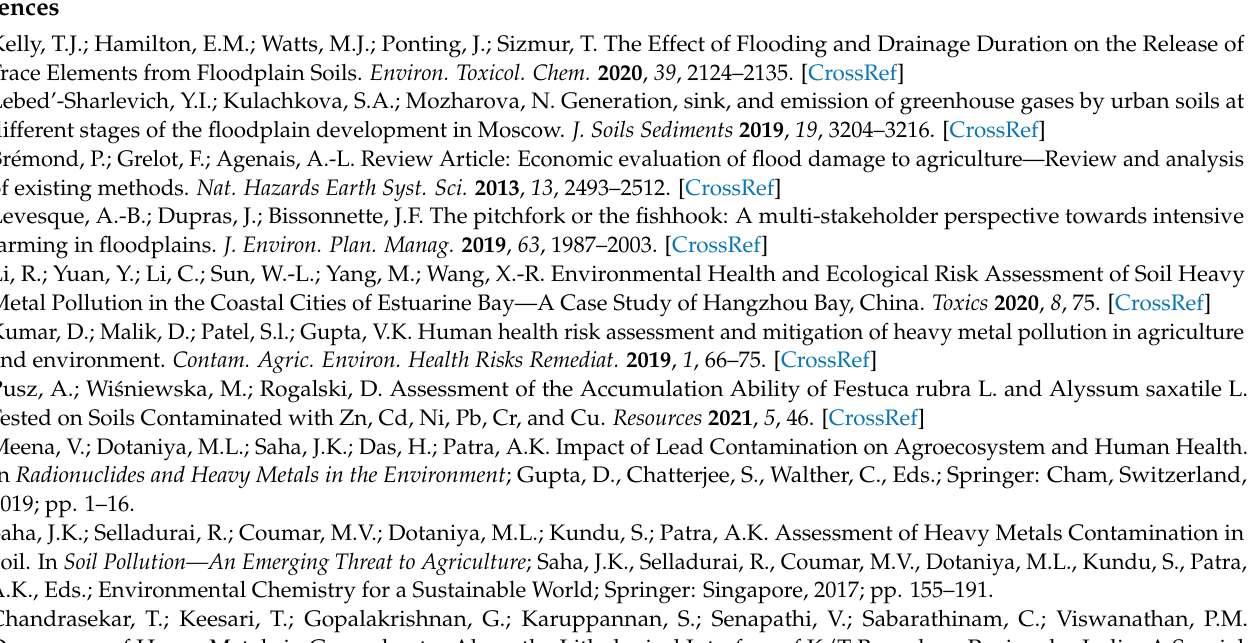
Figure S6: The normalized Ce values in relation to the three principal components; Figure S7: The normalized Cs values in relation to the three principal components; Figure S8: The normalized Ga values in relation to the three principal components; Figure S9: The normalized K values in relation to the three principal components; Figure S10: The normalized La values in relation to the three principal components; Figure S11: The normalized Li values in relation to the three principal components; Figure S12: The normalized Ni values in relation to the three principal components; Figure S13: The normalized Rb values in relation to the three principal components; Figure S14: The normalized Sc values in relation to the three principal components; Figure S15: The normalized Sr values in relation to the three principal components; Figure S16: The normalized V values in relation to the three principal components; Figure S17: Spatial autoregression in the random forest